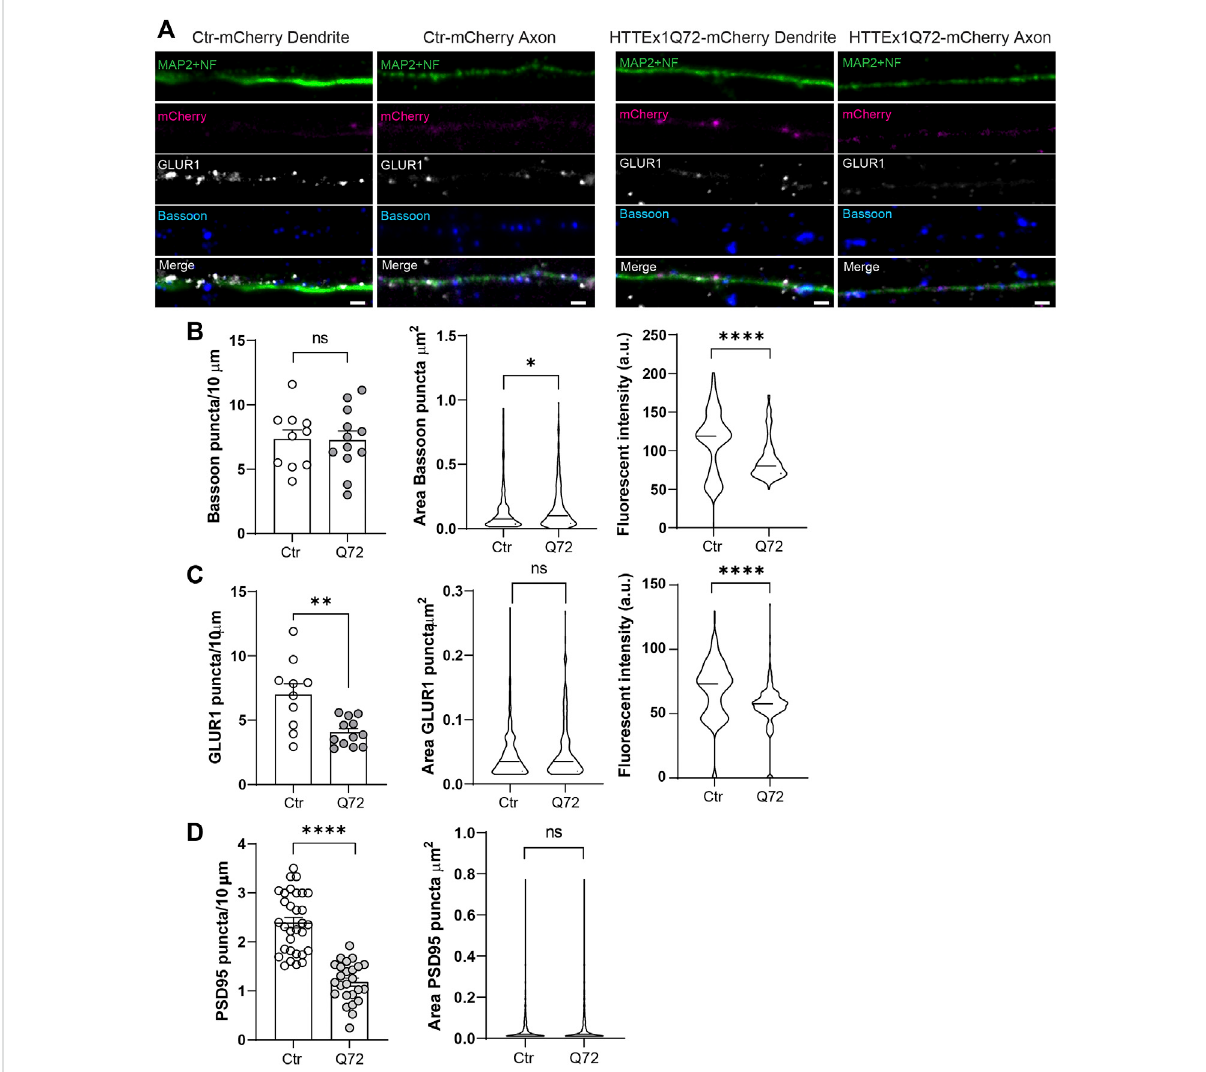
FIGURE 2 Synaptic protein distribution is affected in HTTEx1Q72-mCherry neurons. (A) Indirect immuno fl uorescence representative images of neurites fromCtr-mCherryandHTTEx1Q72-mCherry neuronsonDIV30visualizingMAP2 andNFtogether,mCherry,andthesynaptic markersBassoonand GLUR1. (B) Quanti fi cation of the number of puncta, puncta area, and fl uorescence intensity for presynaptic marker Bassoon in Ctr-mCherry and HTTEx1Q72-mCherryneuronsonDIV30( n =10 – 15cellsfromthreeindependentcultures). (C) Quanti fi cationofthenumberofpuncta,puncta area, and fl uorescence intensity for postsynaptic marker GLUR1 in Ctr-mCherry and HTTEx1Q72-mCherry neurons on DIV 30 ( n = 10 – 12 cells from three independent cultures). (D) Quanti fi cation of the number of puncta and puncta area for postsynaptic marker PSD95 in Ctr-mCherry and HTTEx1Q72-mCherry neurons on DIV 30 ( n = 25 – 30 cells from 3 independent cultures). Scale bar = 5 µm. All averaged data are shown as mean ± s.e.m. (* p < 0.05, ** p < 0.005, and *** p < 0.0001, ns = non-signi fi cant, Student ’ s t-test (Abbr: MAP2: microtubule-associated protein 2,